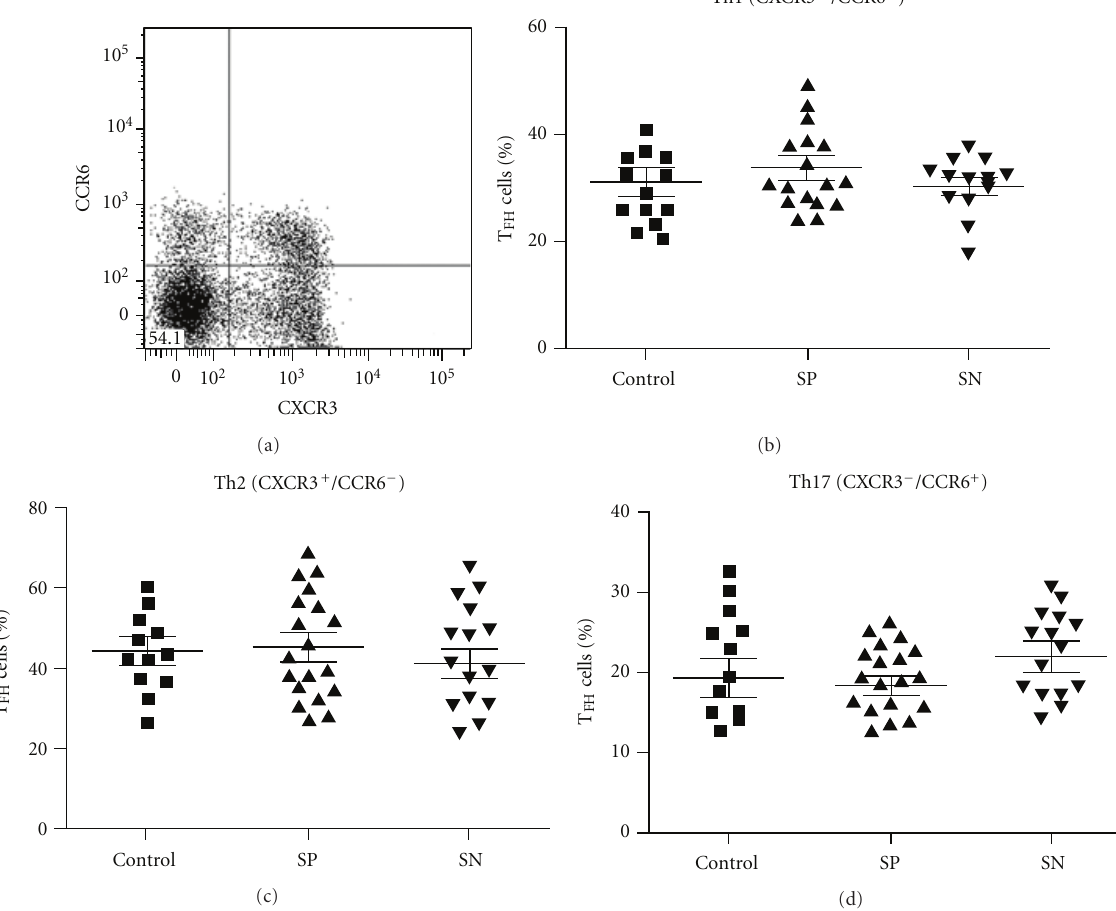
Figure 2: T FH cell subsets in RA. The % of T FH cells with Th1, Th2, or Th17 phenotypes was assessed through expression of the chemokine receptors CXCR3 and CCR6 (see text for details). SP: seropositive, SN: seronegative. Spots represent individual patients. Mean ± SEM are